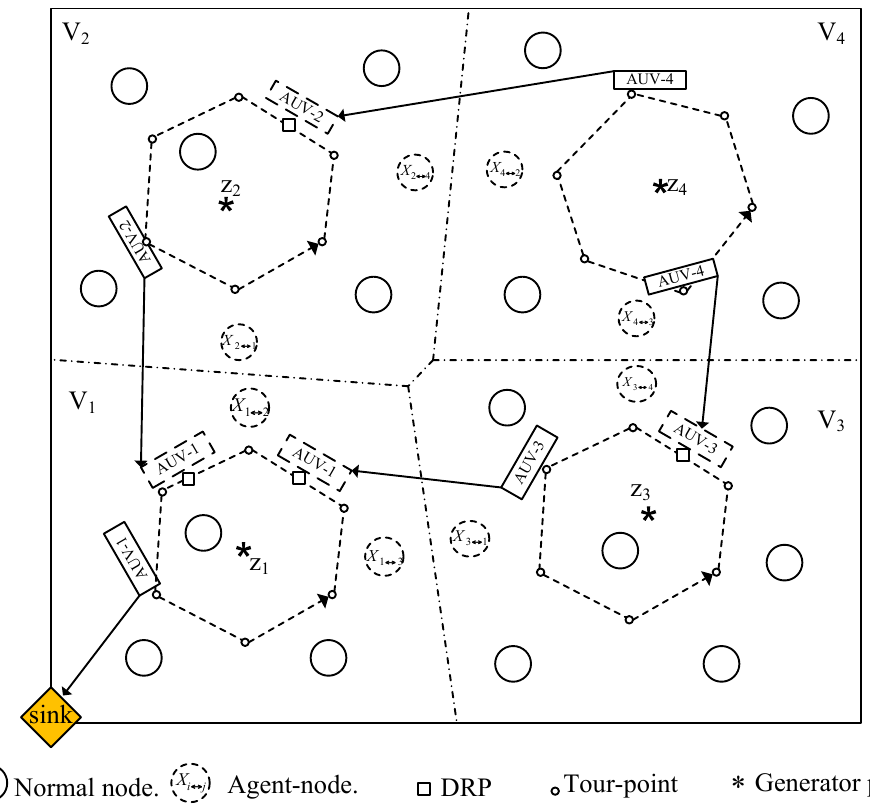
Figure 5. Acoustic Sensor Network with Voronoi Figure 5 . Acoustic Sensor Network with Voronoi regions.